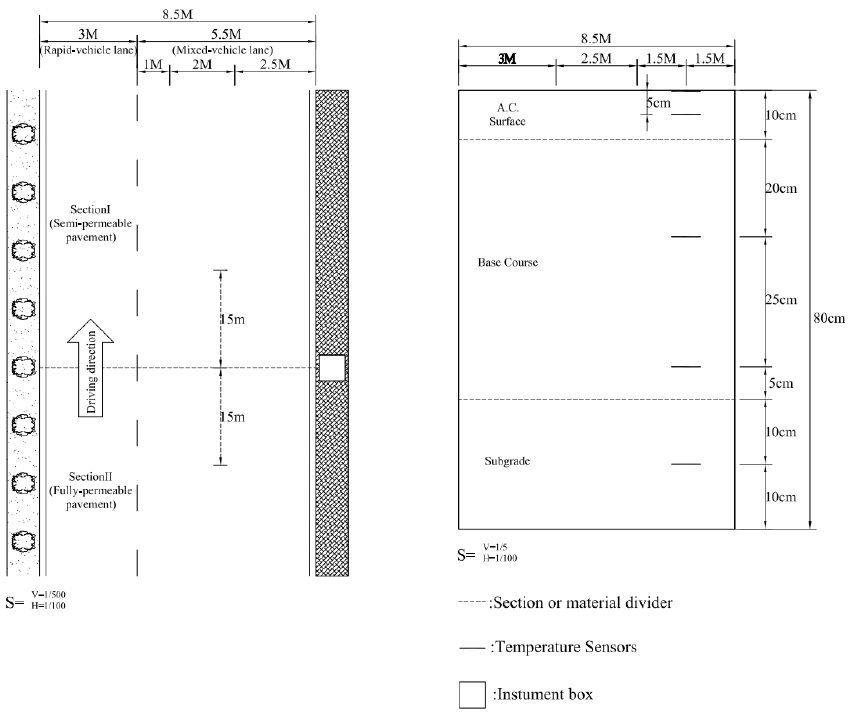
Figure 3. Sketch for the sensor locations in the study.